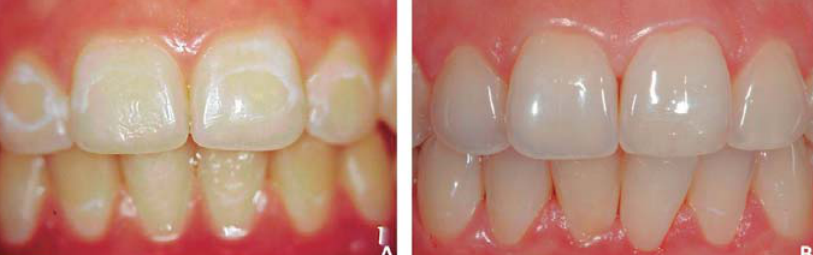
Figure 4- A: Post-orthodontic white enamel stain of hard texture seen in a young patient; B: 23 years after the removal of stains using 18% hydrochloric acid/pumice and dental bleaching with 15% carbamide